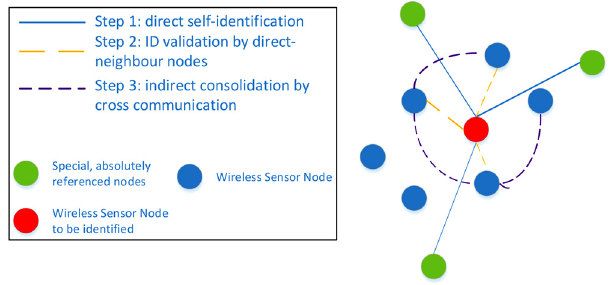
Figure 3. Identi fi cation and veri fi cation